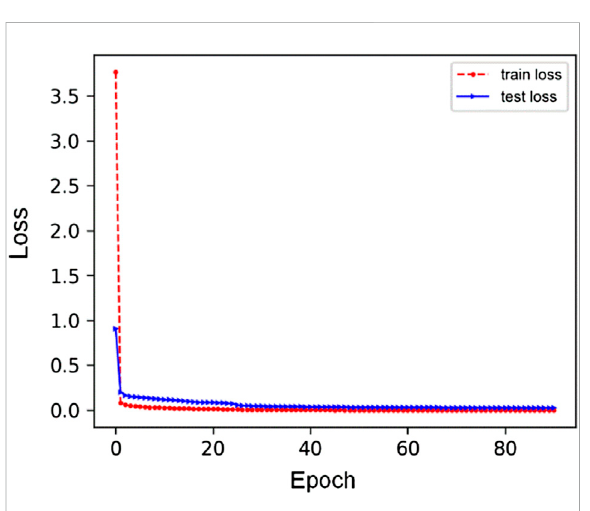
FIGURE 5 Theconvergencetrendoftotallossintrainandtest(redlineis train process, the blue line is test process).